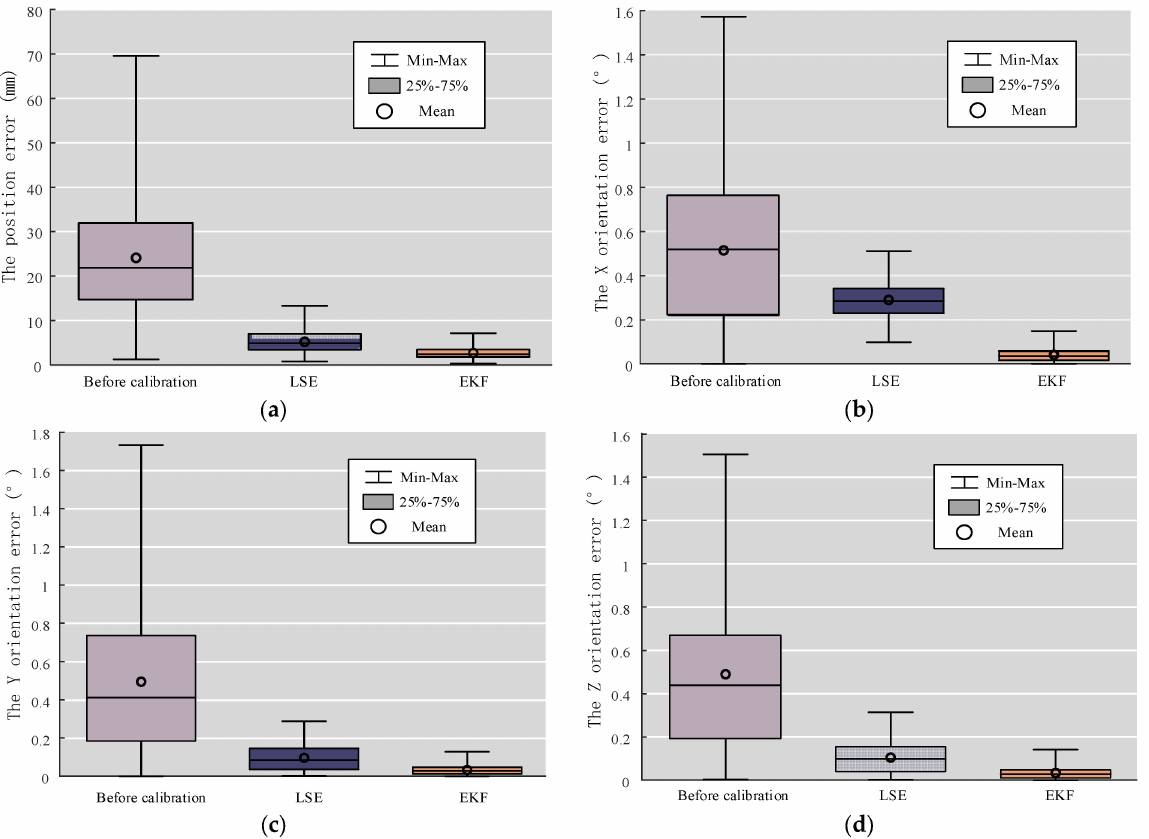
Figure 7. Comparison of the recognition effect of LSE and EKF. ( a ) Change in the position error; ( b ) Change in the X axis orientation error; ( c ) Change in the Y axis orientation error; and ( d ) Change in the Z axis orientation